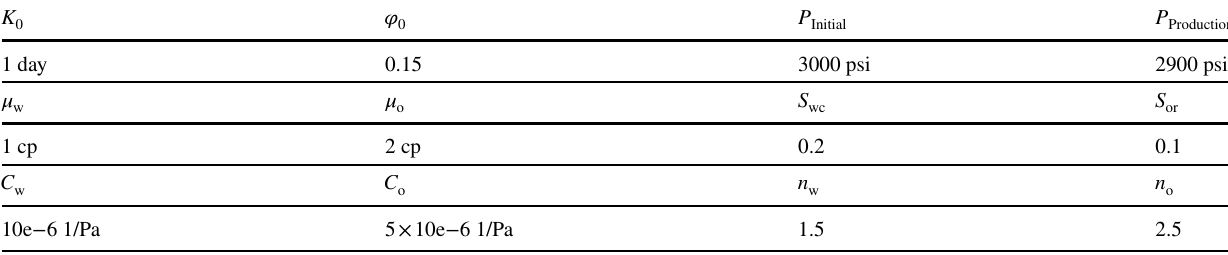
Table 3 Constants used for simulations of the synthetic reservoir K